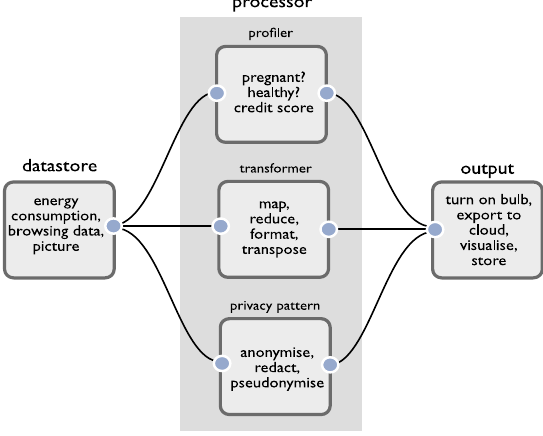
Figure 1. Integrated Development Environment node types.